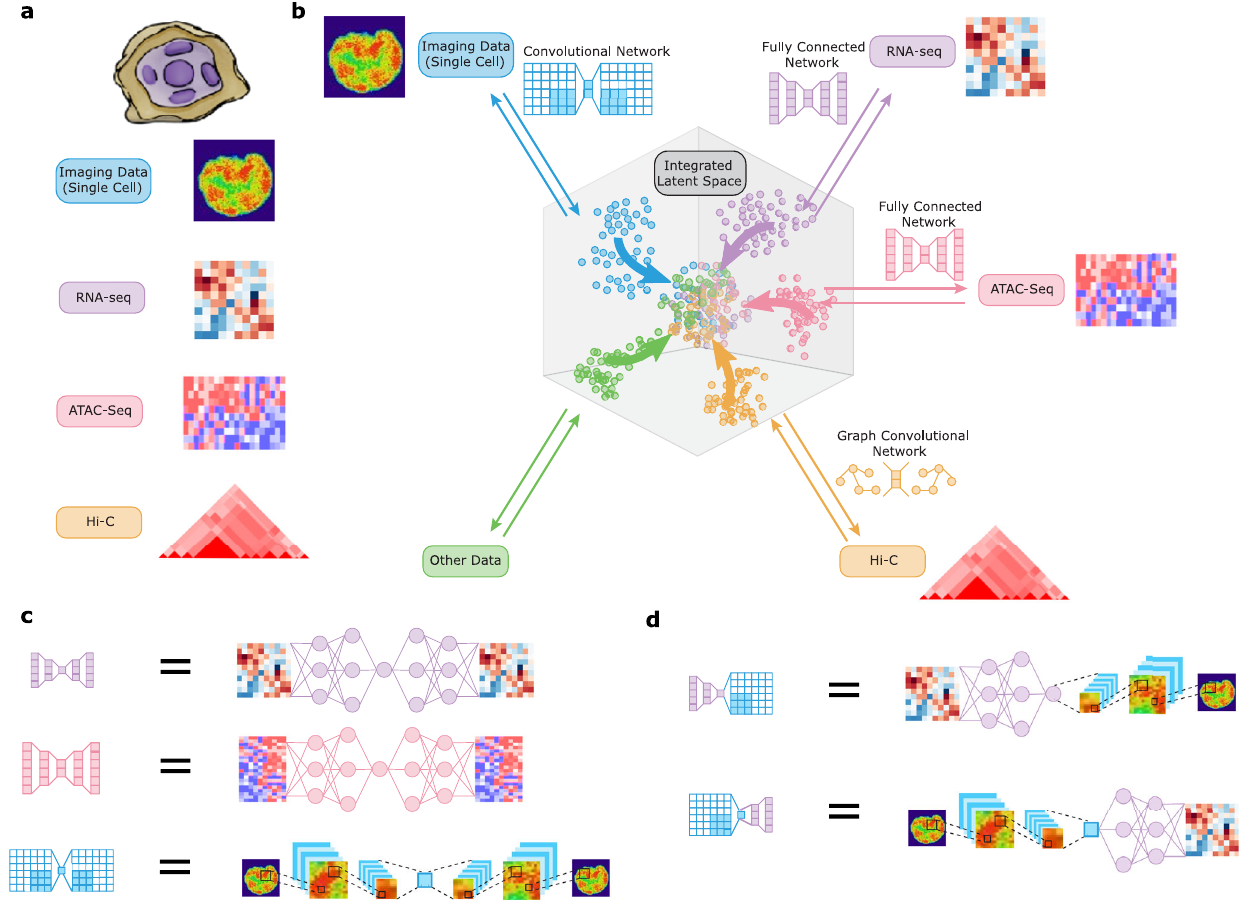
Fig. 1 Schematic of multimodal data integration and translation strategy using our cross-modal autoencoder model. a Each modality or dataset (represented by different colors) presents a different view of the same underlying population of cells of interest. b Our computational strategy to integrate multiple modalities involves embedding each dataset into a shared space that represents the latent state of the cells, such that the distributions of each dataset mapped into the latent space are aligned. c The embedding of each dataset is performed using an autoencoder, a neural network with separate encoder and decoder modules, whose architectures can be customized to the speci fi c data modality (autoencoders for each modality are represented by different colors). d Combining the encoder and decoder modules of different autoencoders enables translation between different data modalities at the single-cell